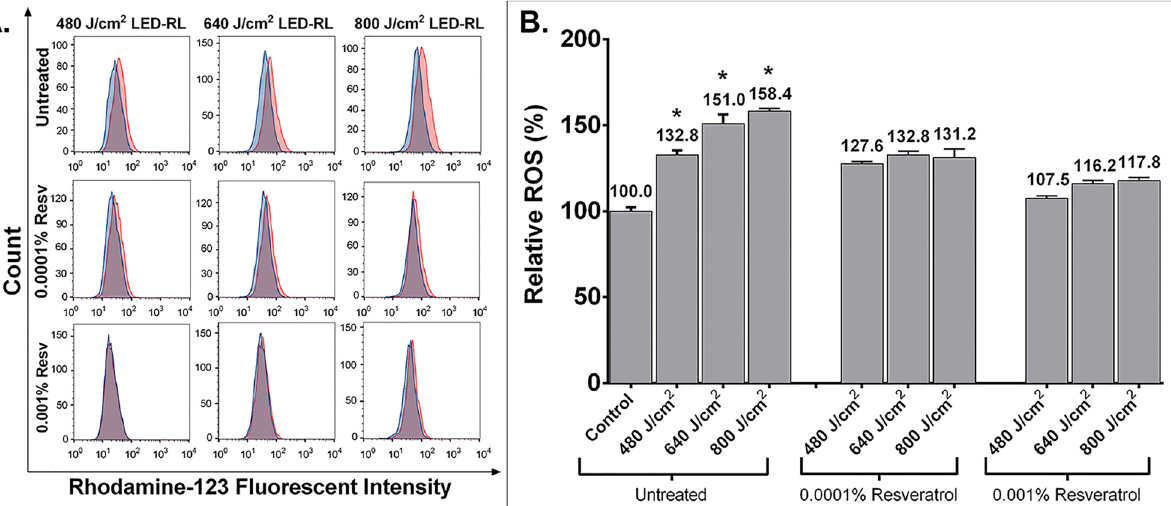
Fig 1. Light-emitting diode generated red light (LED-RL) at a fluences of 480, 640, and 800 J/cm 2 significantly increased reactive oxygen species as measured by DHR. These increases in ROS were significantly prevented by pretreating cells with 0.0001% or 0.001% resveratrol. (A) Representative flow cytometry analysis of untreated and resveratrol pretreated fibroblasts stained with dihydrorhodamine. Red curves represent cells treated with LED-RL at the labeled fluence. Blue curves represent matched controls. (B) ROS levels are presented as median fluorescent intensity of DHR of treated cells relative to matched controls. ROS generation of 480, 640, and 800 J/cm 2 LED-RL was 132.8 ± 2.5% (p = 0.0006), 151.0 ± 5.2% (p = 0.0001), 158.4 ± 1.3% (p = 0.00184), respectively, compared to 100.0 ± 2.2% in control. Pretreatment with 0.0001% resveratrol significantly reduced ROS generation of 480, 640, and 800 J/cm 2 LED-RL to 127.6 ± 1.3 (p = 0.000483), 132.8 ± 2.1 (p = 0.00481), and 131.2 ± 5.1 (p = 0.00022), respectively (p-values compared to matched LED-RL group that was not treated with resveratrol). Pretreatment with 0.001% resveratrol significantly reduced ROS generation of 480, 640, and 800 J/cm 2 LED-RL to 107.5 ± 1.4 (p = 2.3E-05), 116.2 ± 1.7 (p = 0.00018), and 117.8 ± 1.9 (p = 9.6E-07) (p-values compared to matched LED-RL group that was not treated with resveratrol). Error bars represent standard error of the mean. ( * represents P < .05).